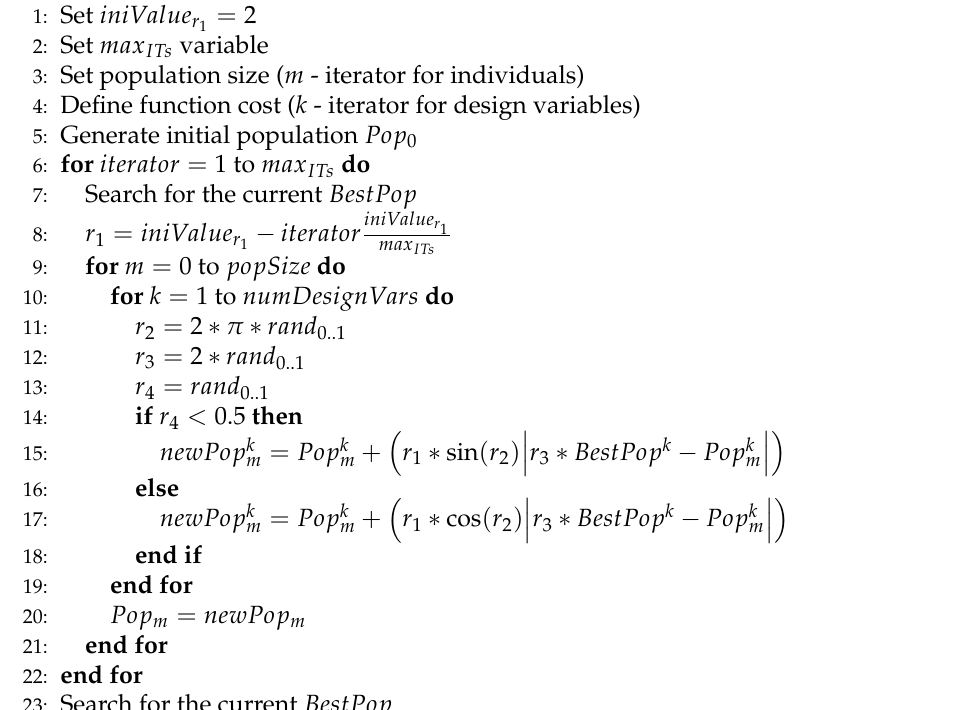
Algorithm 1 The SCA optimization